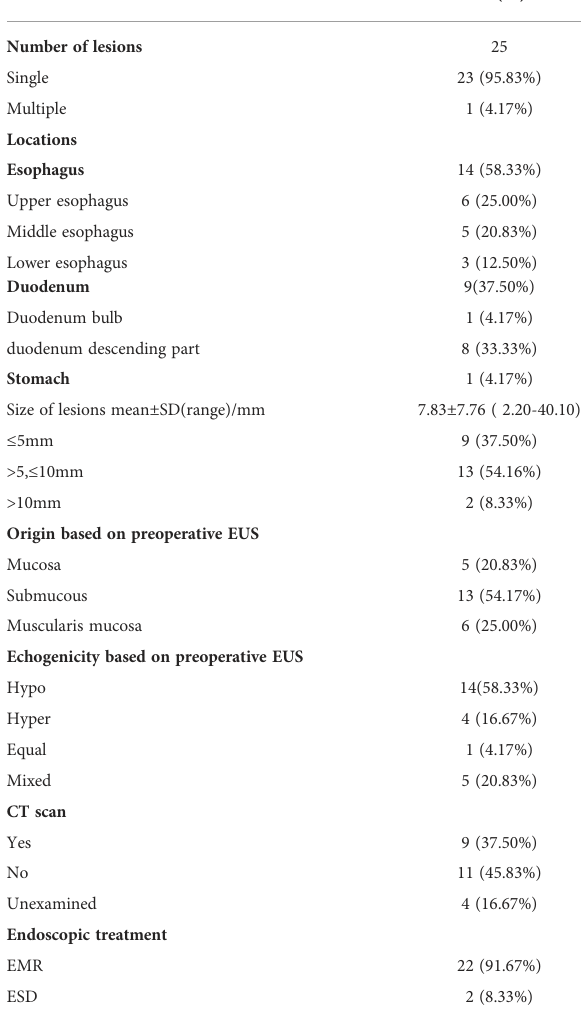
TABLE 2 Endoscopic